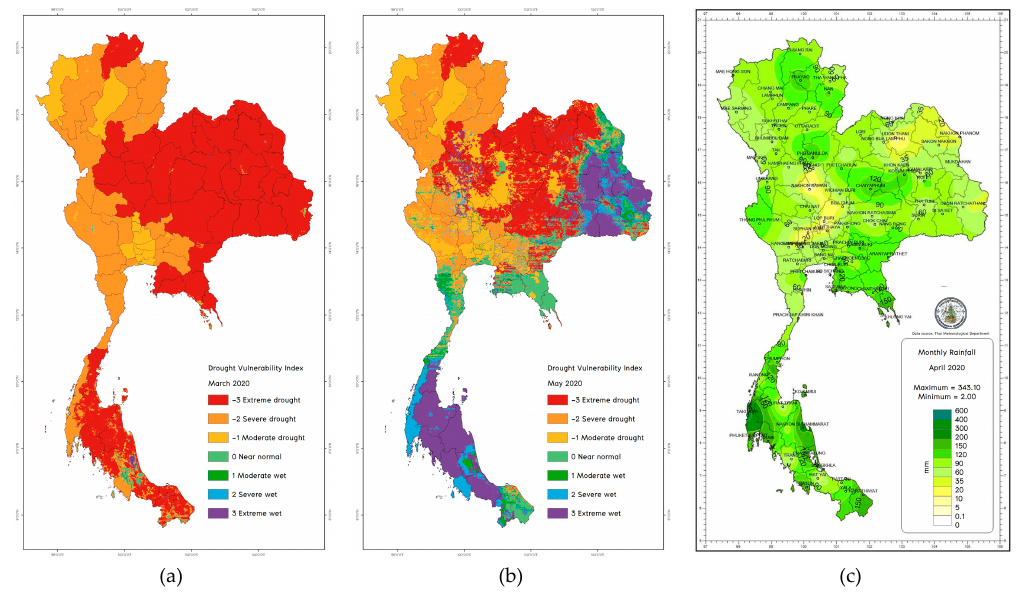
Figure 9. The drought vulnerability index for Thailand in ( a ) March 2020 and ( b ) May 2020, and ( c ) monthly rainfall in April 2020. Precipitation areas are relatively consistent with improved drought